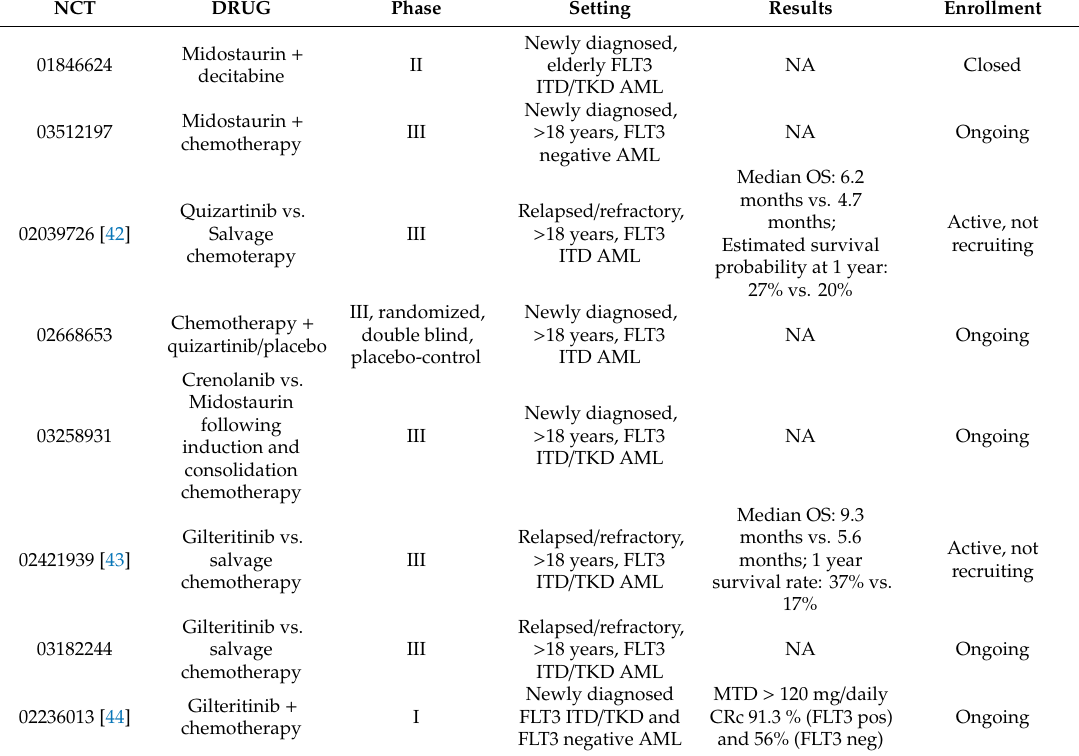
Table 2. FLT3 and IDH1-2 inhibitors clinical